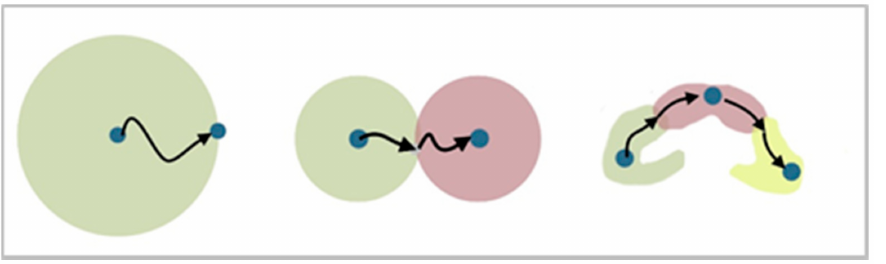
Figure 2. The schematic search space for connecting vertices based on Dijkstra’s algorithm ( left ), bidirectional search ( middle ), and BiasSpan ( right